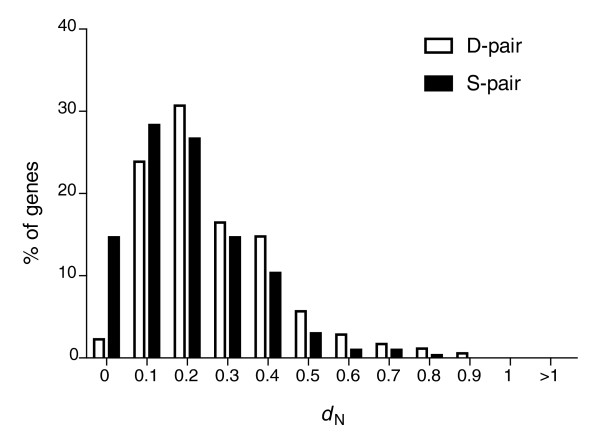
Distribution of non-synonymous substitution rates (dN) for duplicate genes in S- and D-pairs (estimated for the time since the whole-genome duplication event - see text for details).